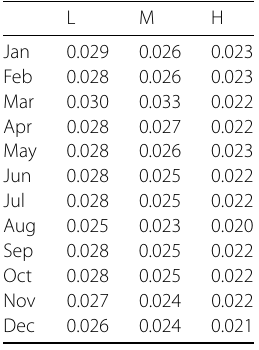
Table 13 Average closeness centrality for each month and risk rating